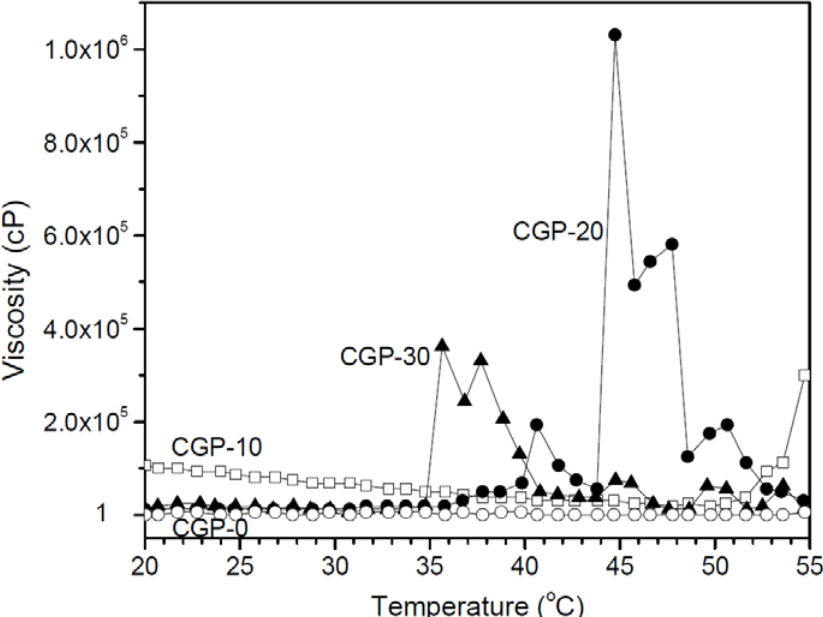
Figure 2. Viscosity versus temperature curves for CGP-0, CGP-10, CGP-20 and